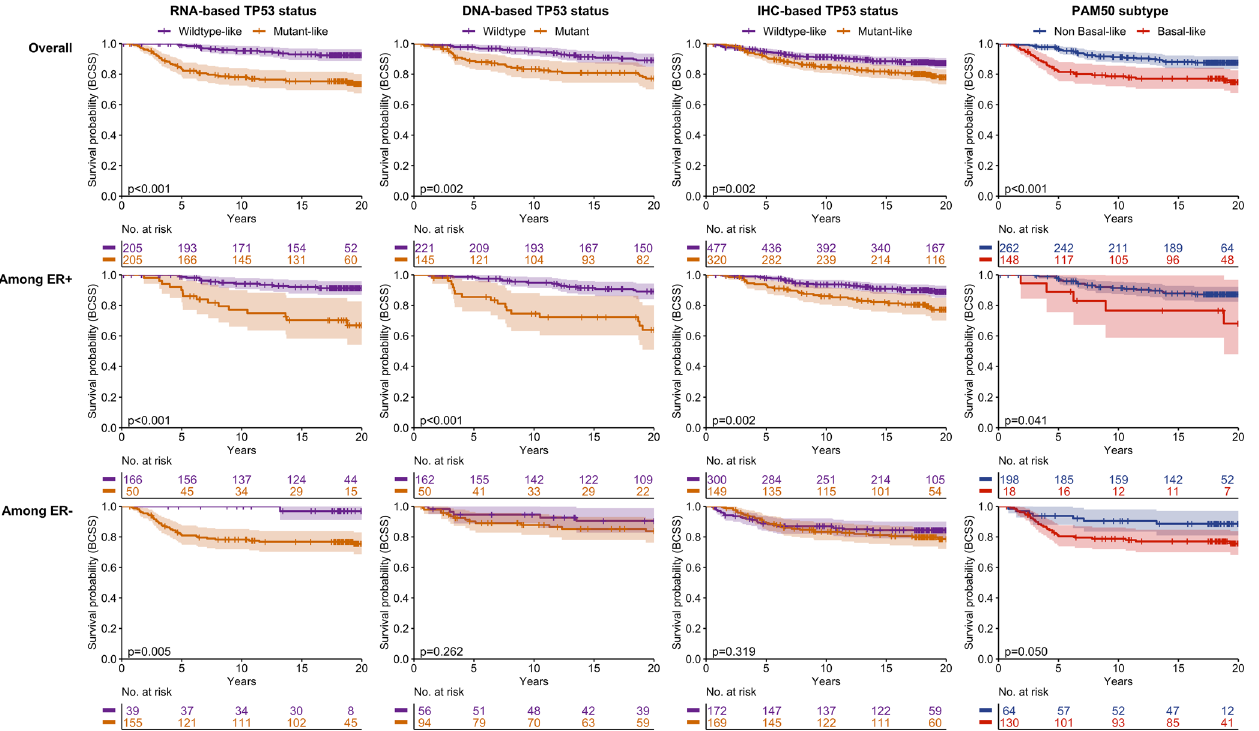
Fig. 1 Kaplan – Meier survival curves for breast cancer-speci fi c survival by tumor subtype, overall and strati fi ed by ER status, among node negative breast cancer cases in CBCS. p values correspond to the log-rank test. The shaded regions correspond to the 95% con fi dence interval. BCSS = breast cancer-speci fi c survival, CBCS = Carolina Breast Cancer Study, ER = estrogen receptor, IHC = immunohistochemistry, ER = estrogen receptor, IHC = immunohistochemistry, PAM50 = Prediction Analysis of Microarray